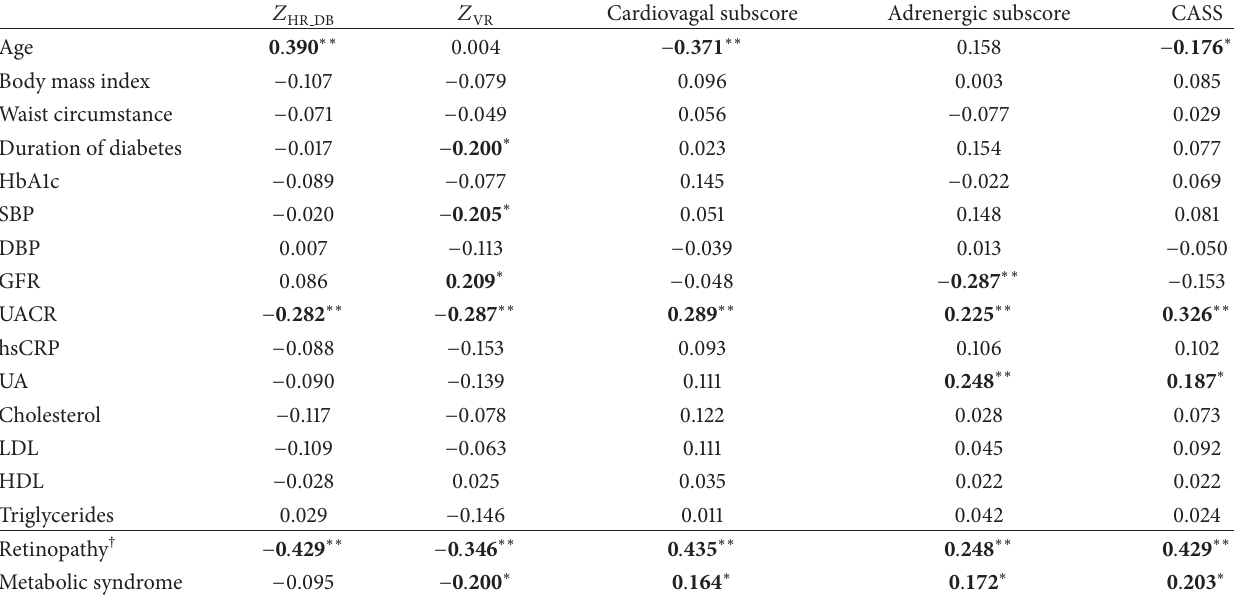
Table 5: Univariate correlation analysis between individual risk factors and autonomic